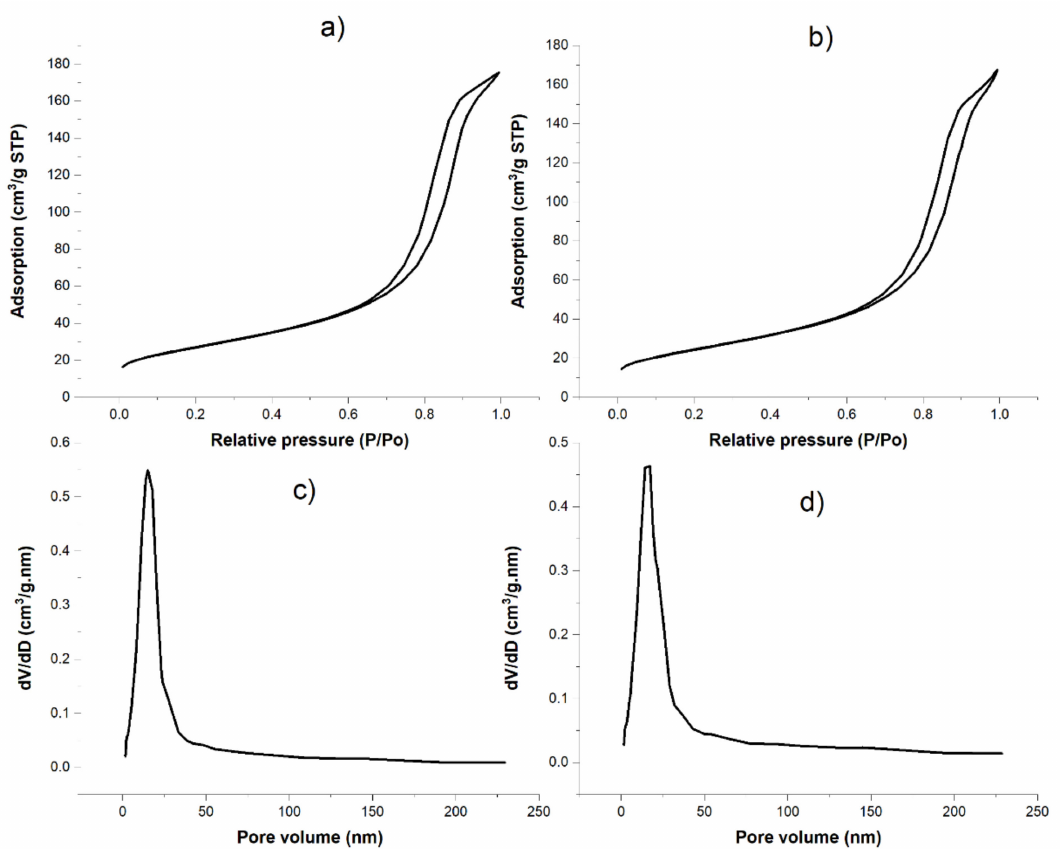
Figure 2. Nitrogen adsorption/desorption profiles for ( a ) Ce 0.75 Zr 0.25 O 2 support and ( b ) 5%Ag/Ce 0.75 Zr 0.25 O 2 catalyst, and pore volume distribution of ( c ) Ce 0.75 Zr 0.25 O 2 support and ( d ) 5%Ag/Ce 0.75 Zr 0.25 O 2 .